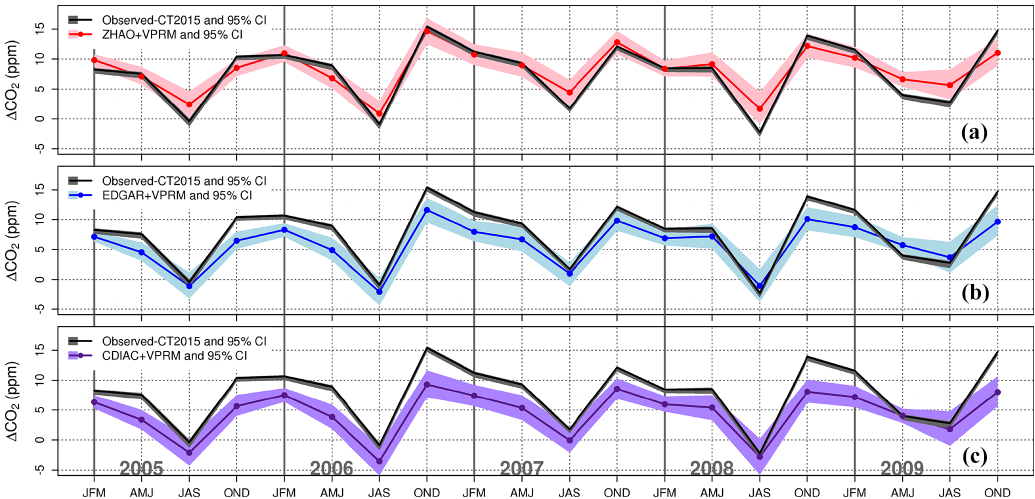
Figure 4. Modeled and measured seasonal (cid:49) CO 2 . CT2015 background is subtracted from observations to provide observed (cid:49) CO 2 (black line), and 95% confidence bounds are derived from bootstrapping hourly afternoon concentrations for each season.